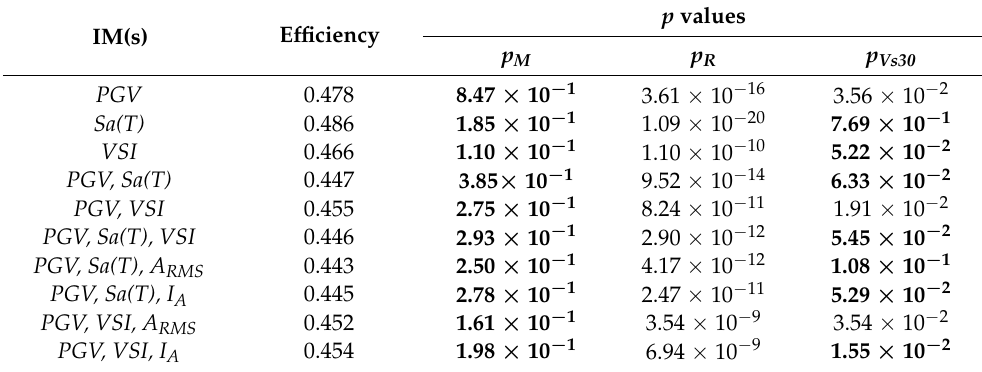
Table 10. Efficiency and p values for frames > 0.5